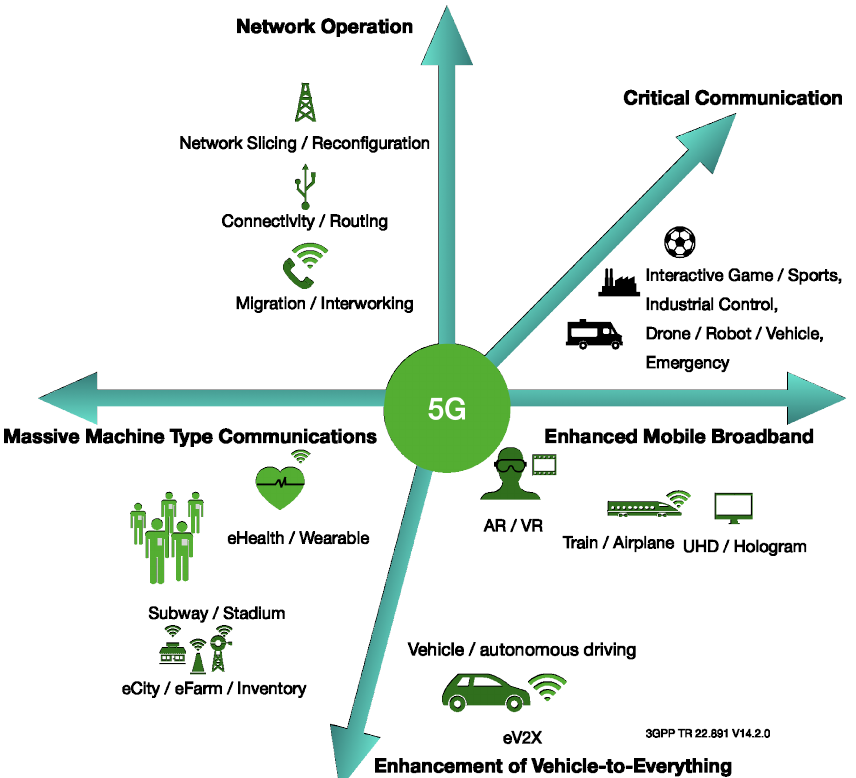
Figure 1. FS_SMARTER service dimension